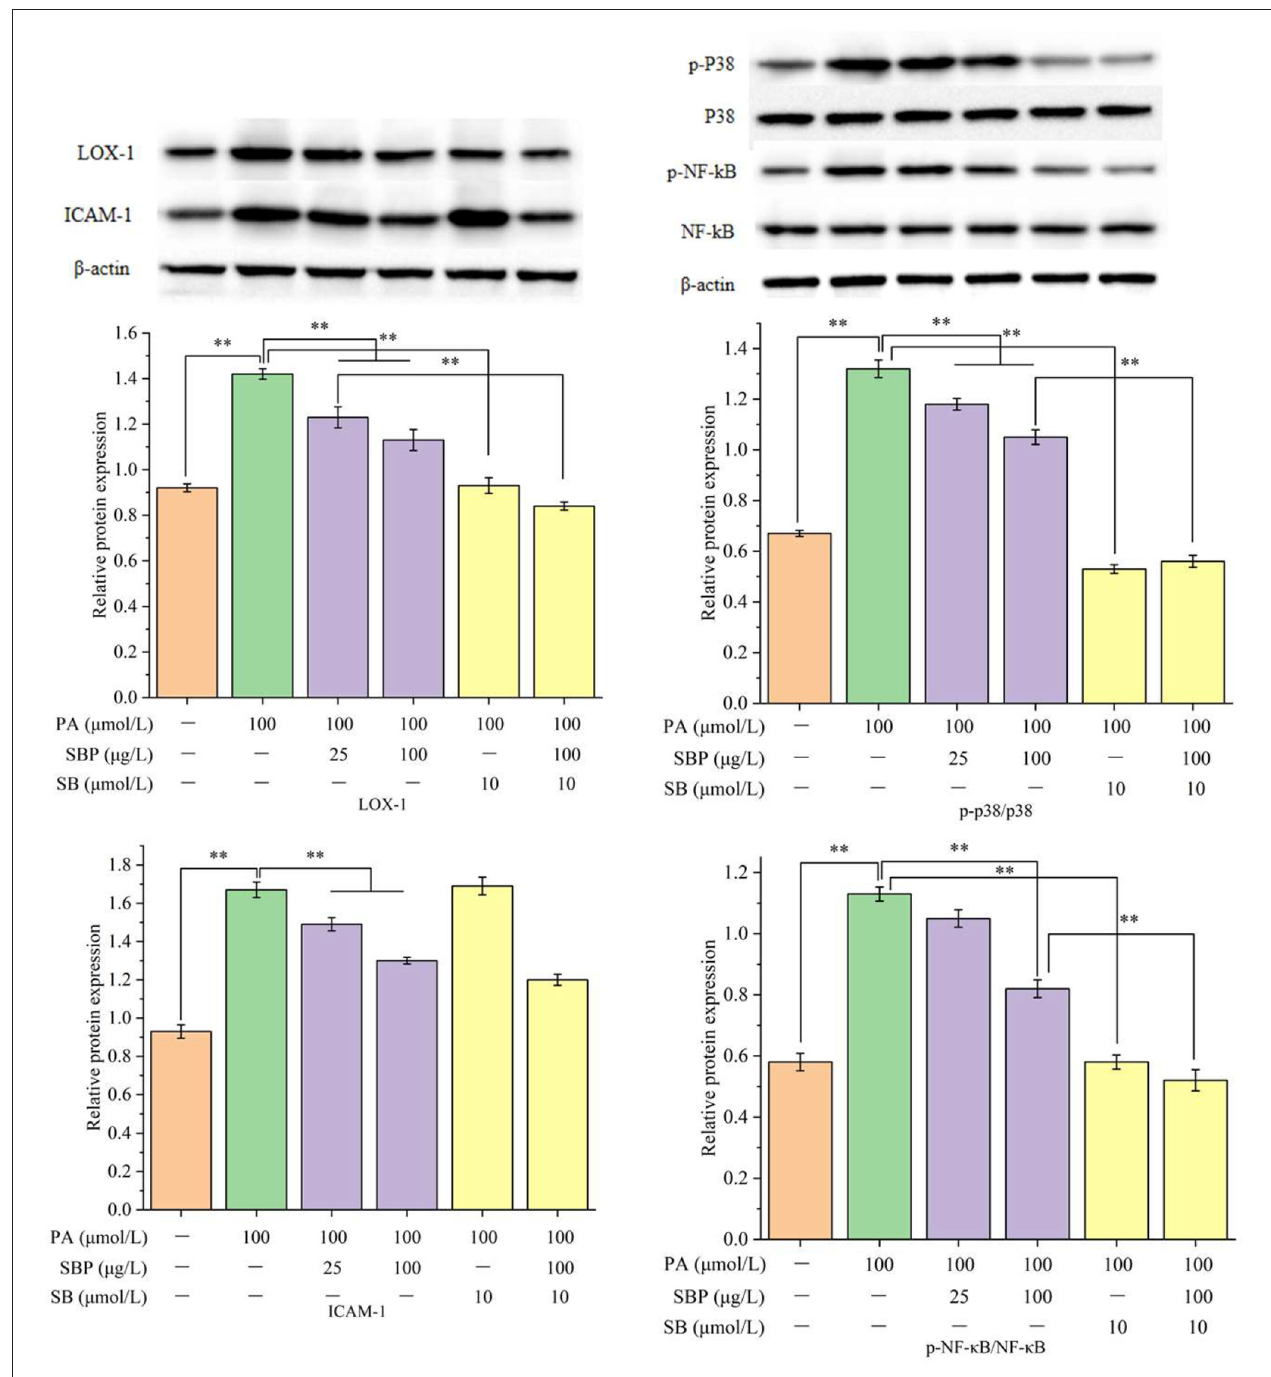
FIGURE 2 | Relative proteins expression (LOX-1, ICAM-1, p-p38/p38, and pNF- κ B/NF- κ B) under different treatments of SBP and SB. The results were expressed as the mean ± SD ( n = 3). ** p < 0.01.